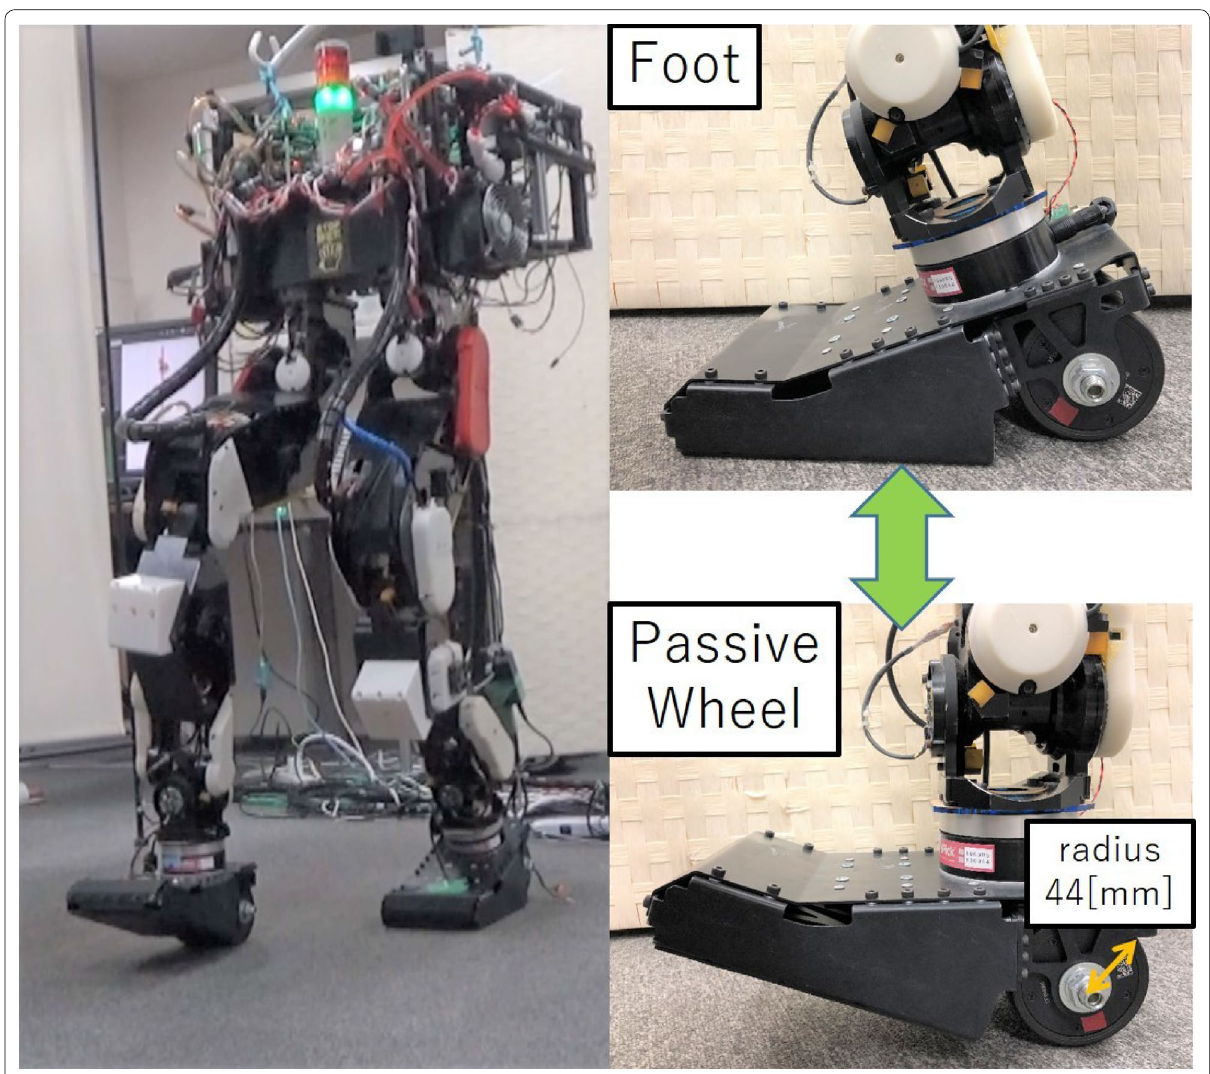
Fig. 1 Locomotion approach of bipedal robot utilizing passive wheel without swing